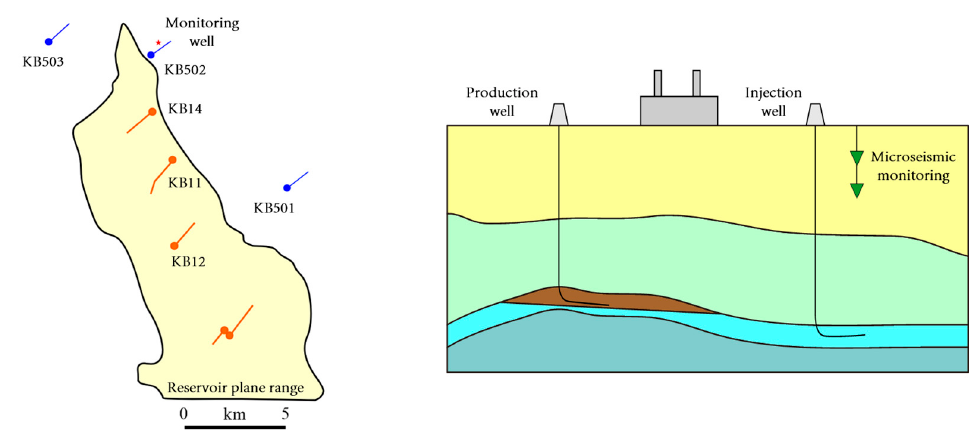
Figure 5. Schematic of the Krechba field showing the location of injection and production wells (modified from Stork A L et al., 2015 [36]; the figure shows injection wells in blue and production wells in orange, and star symbol is the monitoring well).